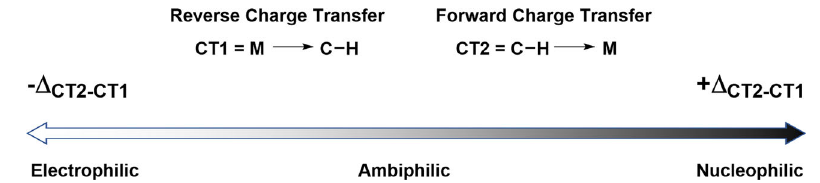
Fig. 1 Continuum of charge transfer. Representation of the continuum of charge transfer in C-H activation reaction pathways.